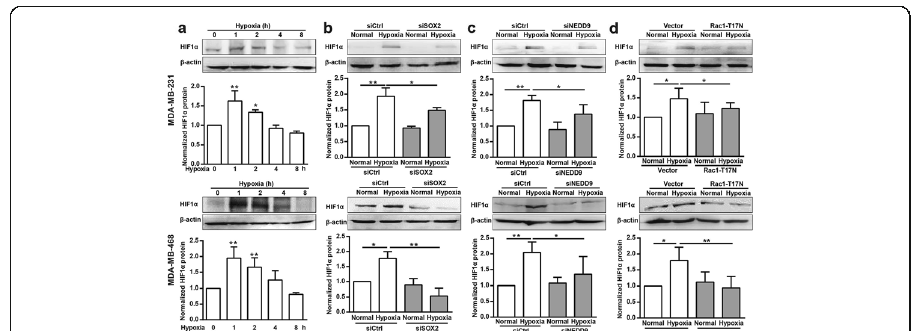
Fig. 5 Rac1, SOX2 and NEDD9 are required for hypoxia-induced HIF-1 α expression. ( a ) MDA-MB-231 and MDA-MB-468 cells were incubated under hypoxia for the indicated periods. Cellular lysates were assayed for HIF-1 α expression via western blotting. HIF-1 α was quantified and normalized against β -actin. * p < 0.05, ** p < 0.01. ( b - d ) After transfection with siSOX2 ( b ), siNEDD9 ( c ) or Rac1-T17 N plasmids ( d ), hypoxic cells were lysed and HIF-1 α expression was determined using western blotting analysis. HIF-1 α was quantified and normalized against β -actin. * p < 0.05, ** p <